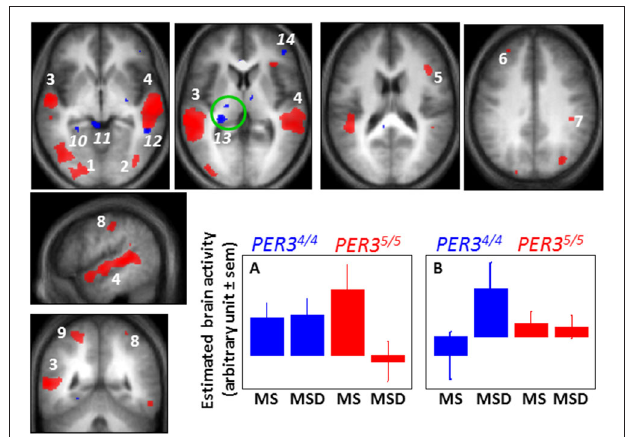
FIGURE 3 | Difference between PER3 4 / 4 and PER3 5 / 5 individuals in the sleep loss-induced changed in brain responses to a working memory task . When comparing brain responses to an auditory 3-back task in the morning after a night of sleep (MS 1.5 h of wakefulness) and in the morning after a night of sleep deprivation (MSD 25 h of wakefulness), PER3 5 / 5 individuals undergo marked decreases in activation in several brain areas of the occipital (1, 2) and temporal (3, 4) cortices, and of the dorsolateral prefrontal (5, 6) and parietal cortex (7–9), while PER3 4 / 4 individuals maintain brain responses in these areas (and do not present significant decreased activations in any brain regions). A representative profile of this brain activity change is displayed in panel A (similar profiles were observed for red areas 1–9). In contrast, when comparing the same sessions, PER3 4 / 4 individuals present increased activation (blue) in the parahippocampus (10), superior colliculus (11), temporal cortex (12), pulvinar (13), and ventrolateral prefrontal cortex (14), while no increased activation is observed in these regions in PER3 5 / 5 (and in any other brain regions). A representative profile of this brain activity change is displayed in panel B (similar profiles were observed for blue areas 10–14). A significant negative association was found between overnight change in brain response in the pulvinar (green circle) and self-reported daytime propensity to fall asleep in everyday life across all the subjects of the study (irrespective of genotype), further suggesting a central role for the pulvinar in wakefulness regulation. [Adapted with permission from Vandewalle et al.